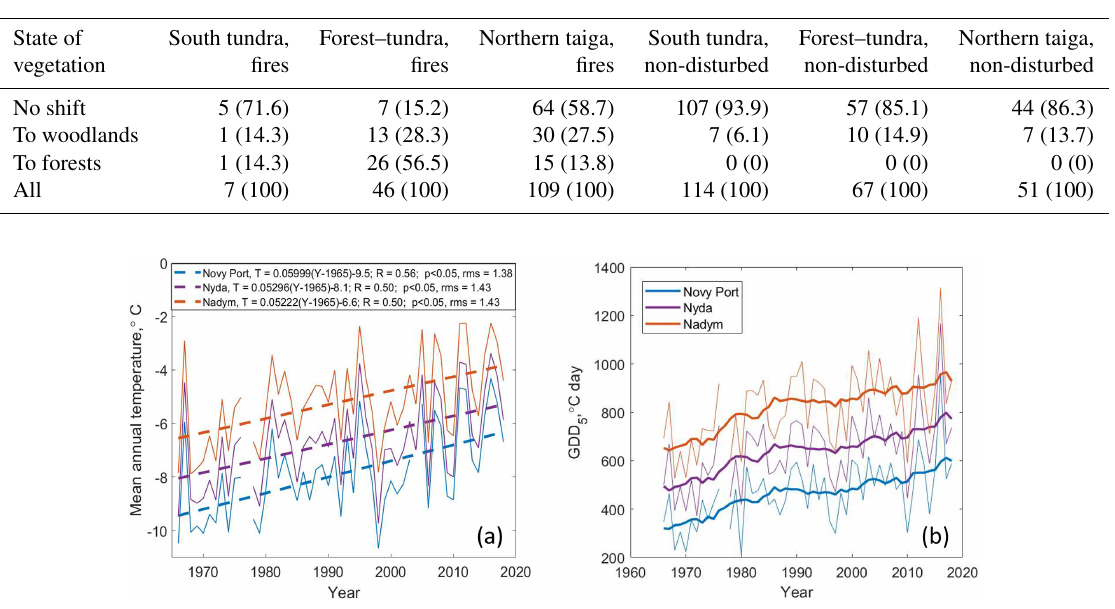
Figure 4. (a) Time series of mean annual temperature (solid) and corresponding linear fits (dashed). In the legend, T is the mean annual temperature and Y is the year. (b) Time series of growing degree days (thin solid curves) and 10-year running average (thick solid